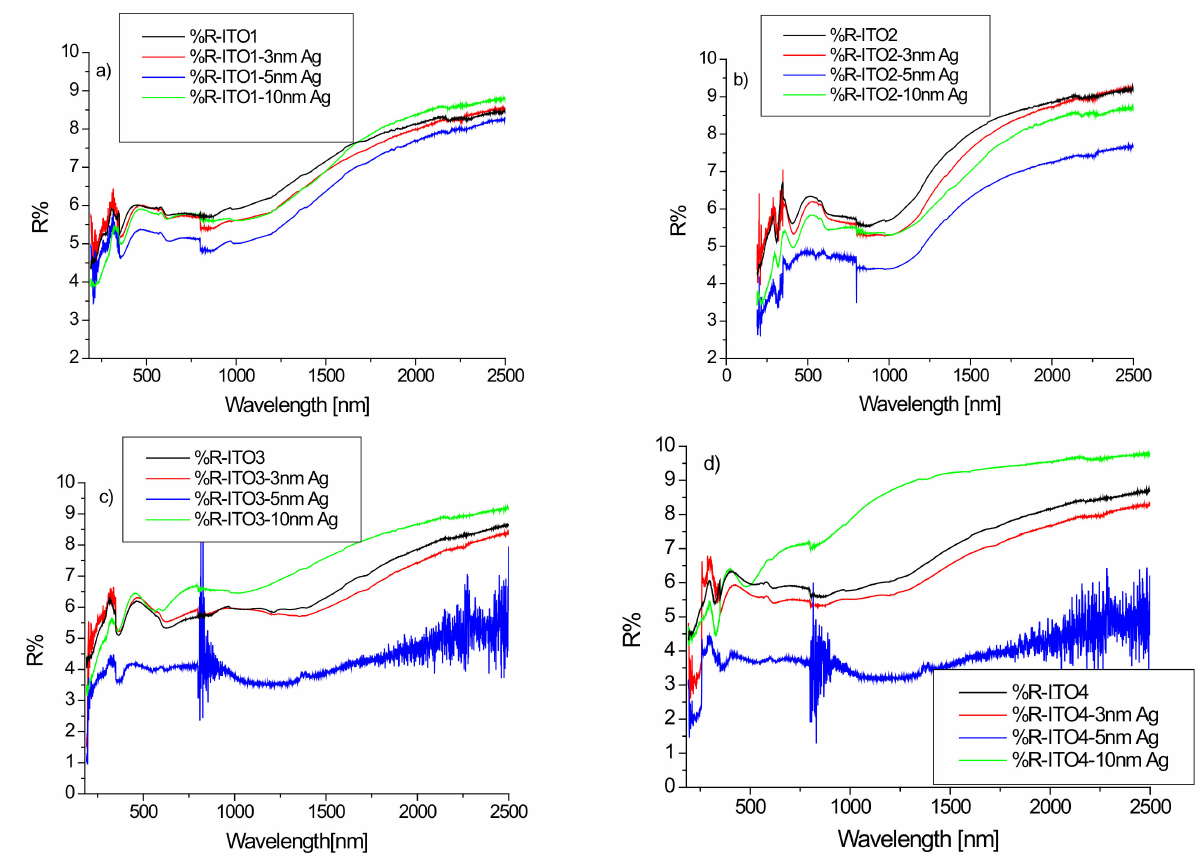
Figure 3. ( a – d ) Reflectance spectra of ITO/glass and Ag/ITO/glass layers for various ITO layers.